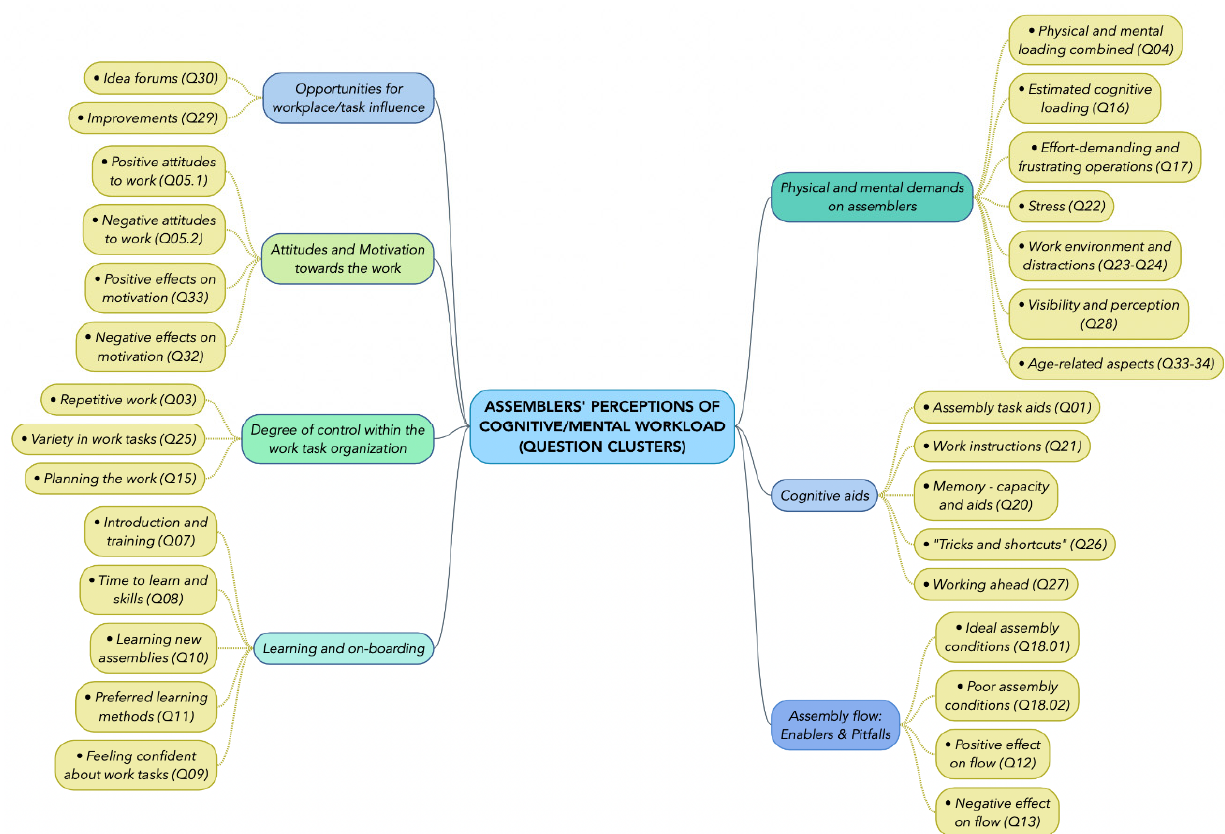
Figure 2. The initial “clustering” of related questions (see full questions in Appendix